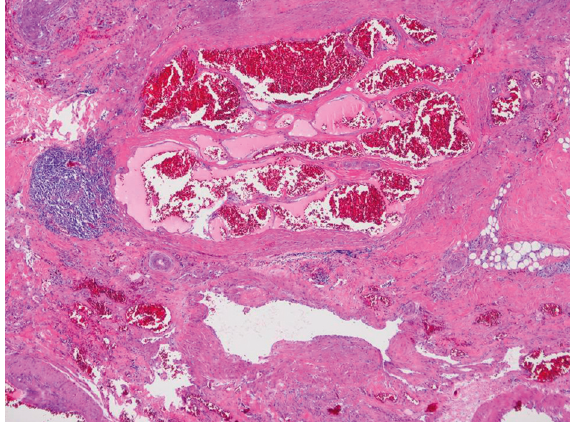
Figure 2: Histology (40x) shows a central cluster of thin-walled vessels, adjacent small lymphoid aggregate, focal adipose tissue, and a large vessel with a thick muscular